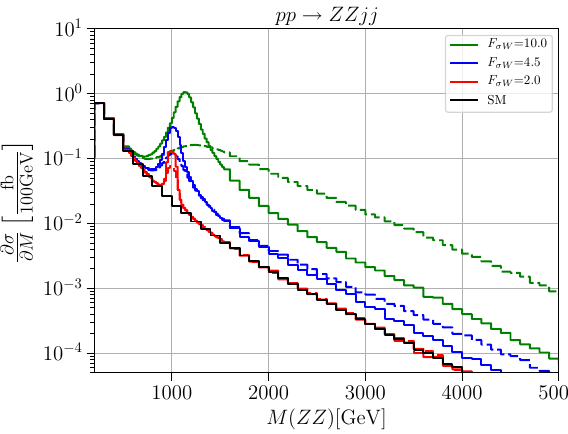
Fig. 4 Cross sections differential in the diboson invariant mass for the process pp → Z Zjj . The solid black line shows the Standard Model differential cross section, the green, blue and red lines the cross sections with a scalar resonance with mass m σ = 1TeV and coupling of F W σ = 10 . 0 TeV − 1 , F W σ = 4 . 5TeV − 1 and F W σ = 2 . 0TeV − 1 , respectively. Solid: unitarized; dashed: naive result. Cuts: M jj > 500 GeV, Δη jj > > 20 GeV 2 . 4, | η j | < 4 . 5, p j T